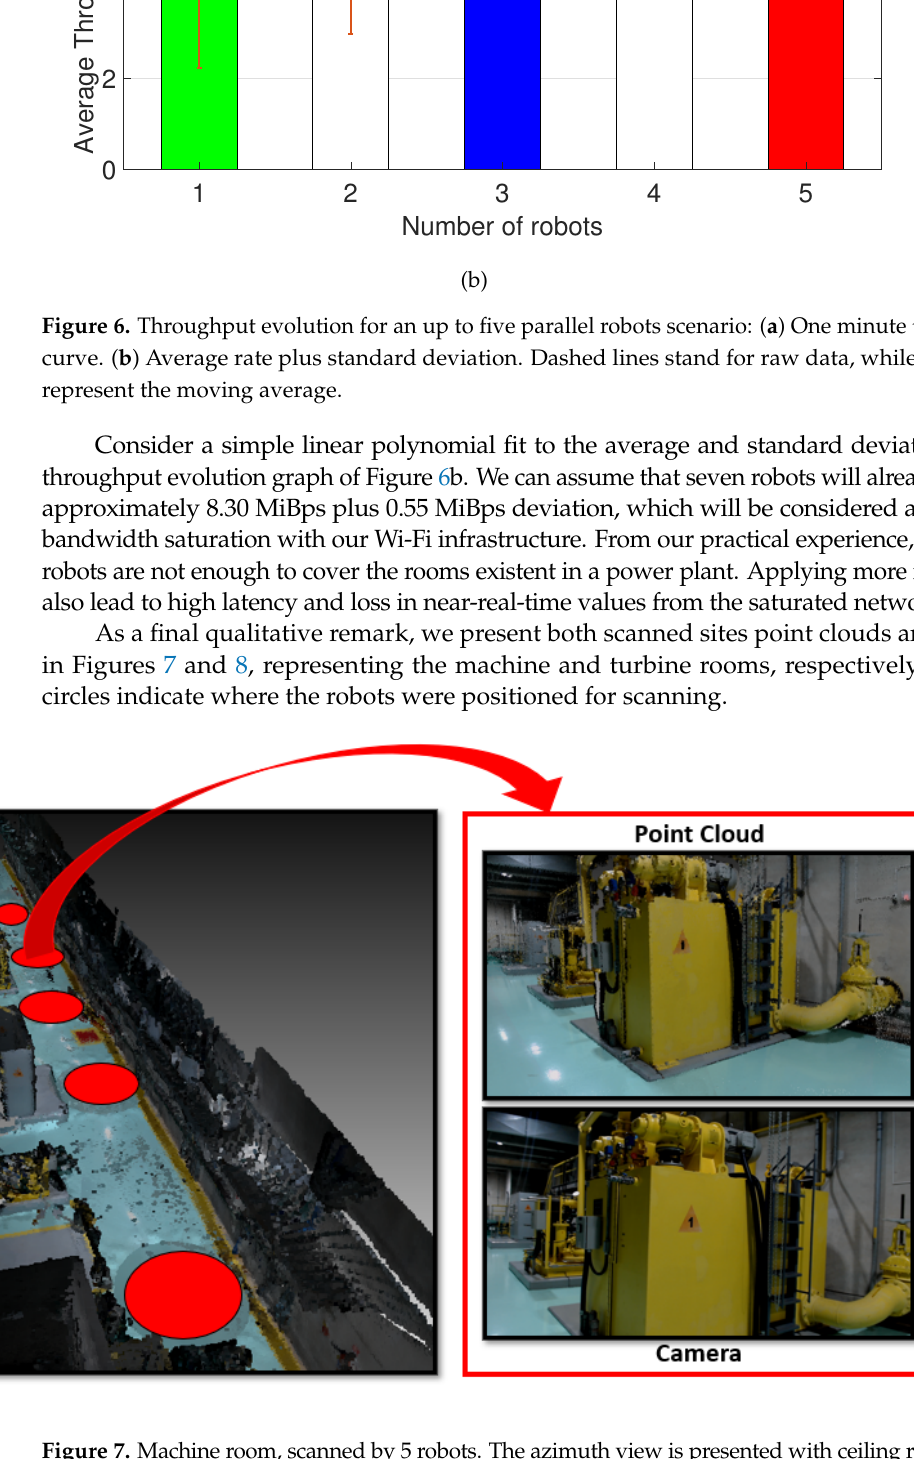
Figure 7. Machine room, scanned by 5 robots. The azimuth view is presented with ceiling removed for better interpretation. Red dots indicate the robots positions. Point cloud and camera views are